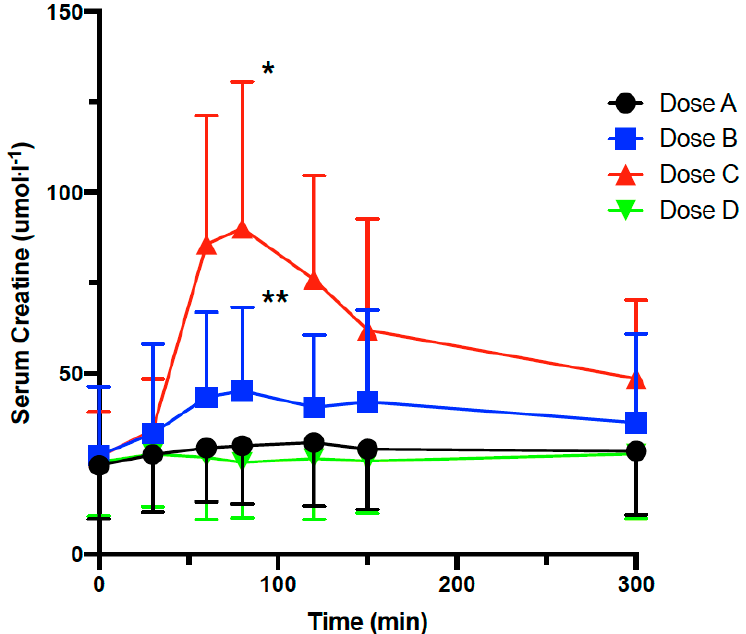
Figure 4. Pharmacokinetic of LMP formulated creatine in humans in a randomized double-blinded placebo-controlled cross-over study. Serum creatine concentration following oral administration of placebo or LMP CARN (500 mg) combined with LMP Cr at 100, 200 or 500 mg in 17 healthy individuals. Dose A = LMP CARN 500 mg/LMP Cr 100 mg, Dose B = LMP CARN 500 mg/LMP Cr 200 mg, Dose C = LMP CARN 500 mg/LMP Cr 500 mg, Dose D = non-nutritive placebo. Data are shown as mean and standard deviation (above or below). ** indicates Dose B significantly different from Dose D at 90 min ( p = 0.01). * indicates Dose C is significantly different from Dose D at 90 min ( p <